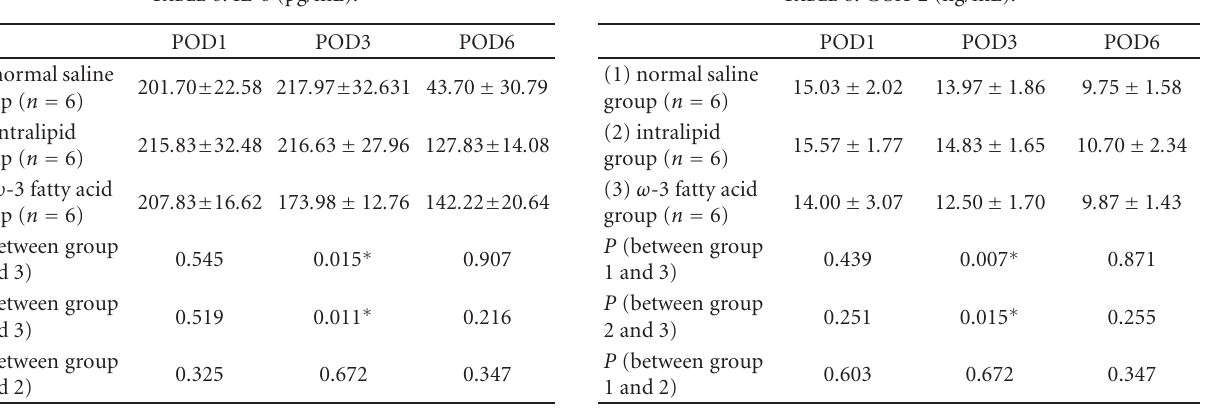
Table 6: IL-6 (pg/mL).